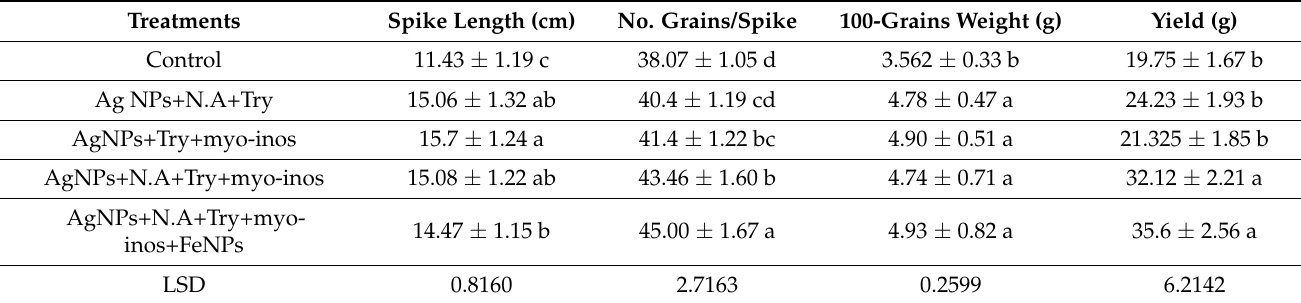
Table 5. Effect of different treatments of blended NPs on yield of